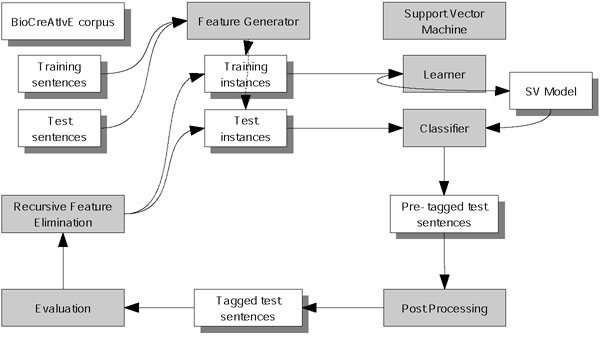
System architecture. The overall system architecture, including the recursive feature elimination process.